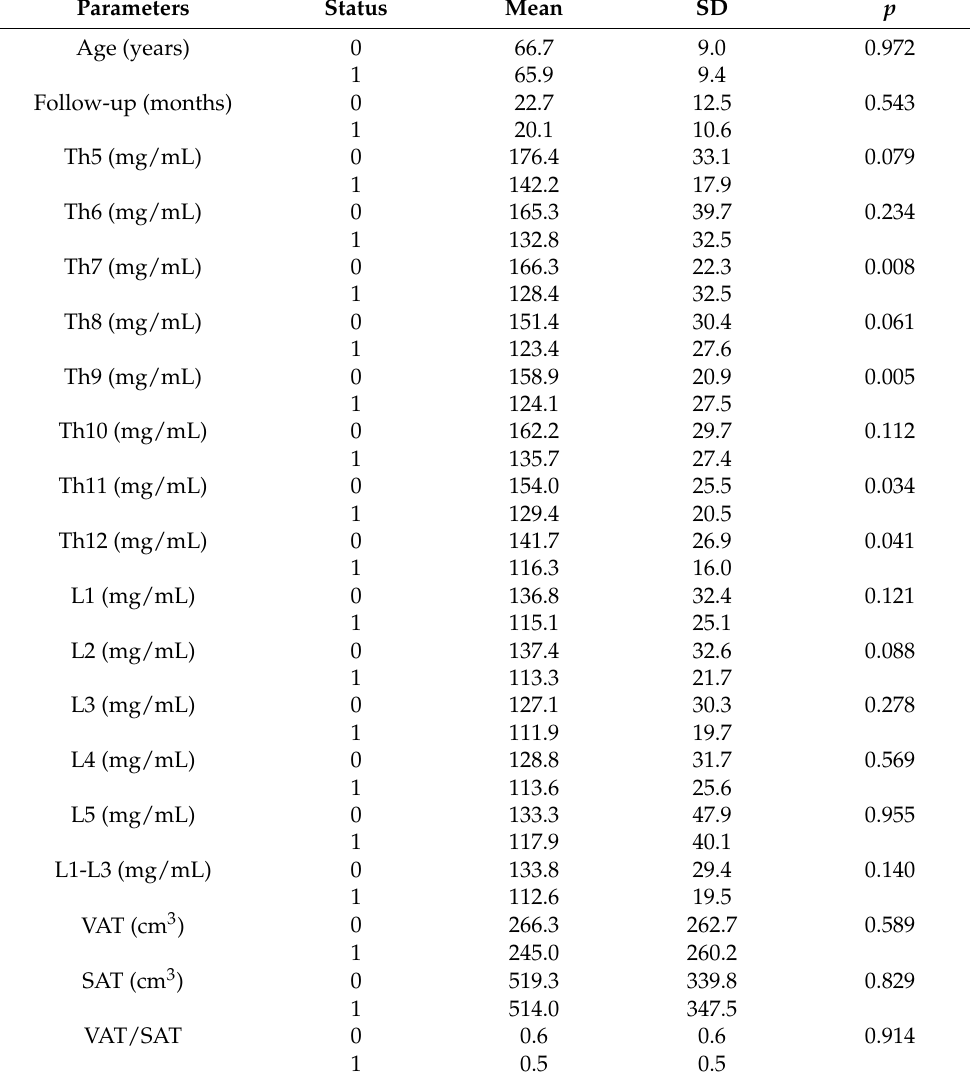
Table 1. Bone mineral density (BMD) is displayed from Th5 to L5. Subcutaneous adipose tissue (SAT) and visceral adipose tissue (VAT) are measured at the level L4/5. Parameters were compared between the two groups with Wilcoxon-signed rank-tests.